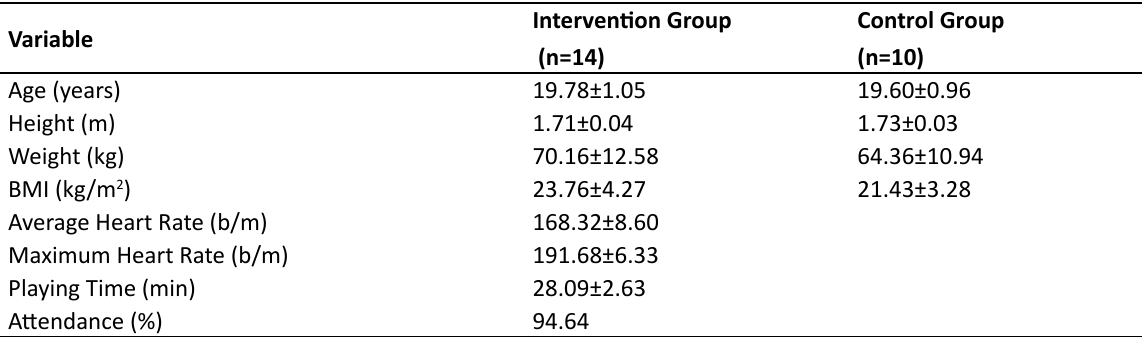
Table 2. General Characteristics of Participants